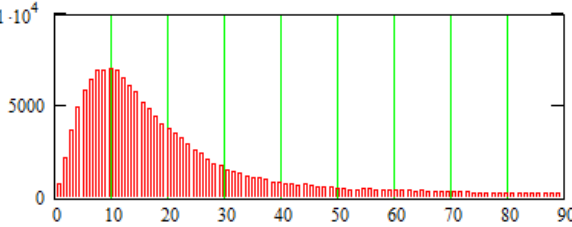
Figure 13. Histogram of angles between fibers in experiment and model data. The human heart dataset is used. X -axis is the angle; Y -axis is the number of points in the segments; the segment [ 0,90 ◦ ] was divided into 100 segments of equal length.